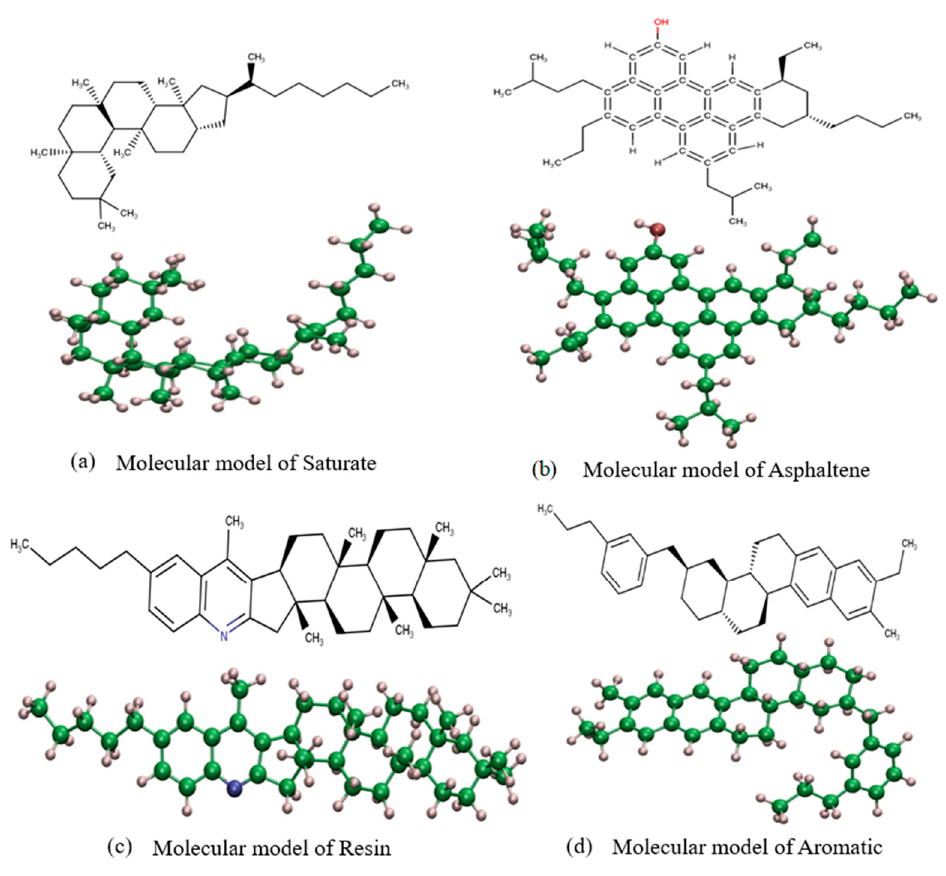
Figure 1. Molecular structure of SARA molecules: ( a ) saturate, ( b ) asphaltene, ( c ) resin and ( d ) aromatic (adapted from [27]).